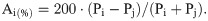
Asymmetry maps of (A) the patient with left ICA occlusion accompanied by old cerebral infarction in the left medial frontal lobe, and (B) the patient with near-occlusion of the left ICA.Asymmetry maps were created according to the following equation:
Ai(%)=200⋅(Pi−Pj)/(Pi+Pj).Here Ai was the value of voxel i in the asymmetry map, and Pi or Pj represented the value of the voxel i or j in the parametric image respectively, where j indicated the contralateral location to i. Only positive Ai was displayed by the color scale and overlaid on the corresponding voxels of the symmetric MRI template. Infarcted lesions and areas where the kinetic parameter K1 could not be calculated because of noise or an extraordinarily low count of delayed SPECT images were masked.